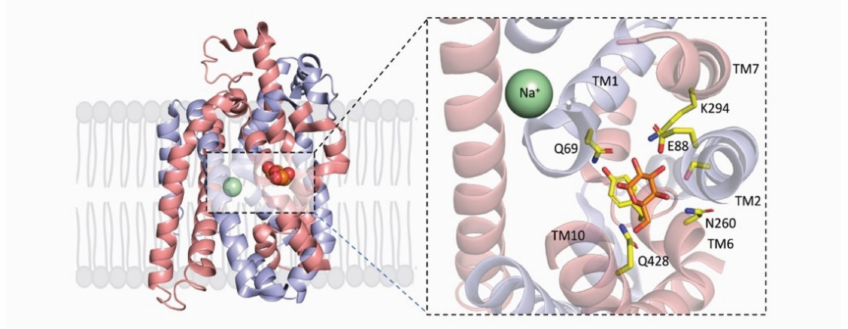
Figure 3. The core domain of the inward-occluded conformation of vSGLT (PDB: 3DH4). The charac- teristic 5TM inverted repeat is shown in blue (TM1–TM5) and red (TM6–TM10) with the driving ion Na + (green) and substrate galactose (orange) spheres. Inset, shows the location of Na + (green) in relation to galactose (orange) with their corresponding coordinating residues. The sugar is accom- modated in the middle of the membrane by a space created in part by “kinked” (unwound) helices TM1 and TM6. As with LacY , the sugar is coordinated by H-bonds to polar side chains on TM1, TM2, TM6, TM7 and TM10) and hydrophobic stacking of the pyranose ring to Trp263. The presumptive sodium binding site is located between TM1 and TM8 some 10 Å distant from the sugar binding site. Atoms are displayed in ball-and-stick form with oxygen colored (red) and nitrogen colored